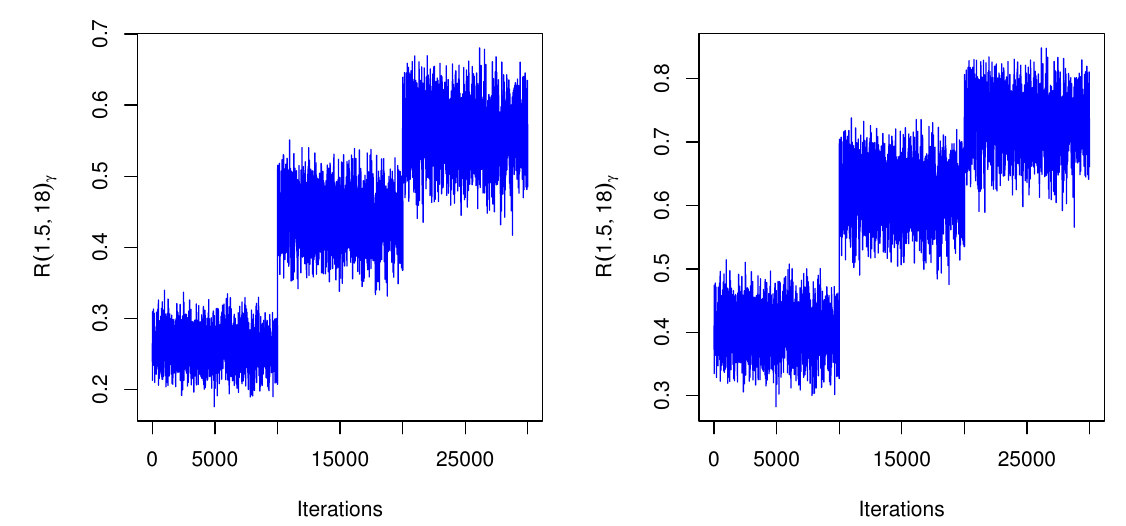
Figure 7. The auto-correlation of fuzzy reliability ˜ R by MCMC results of TIIHLW